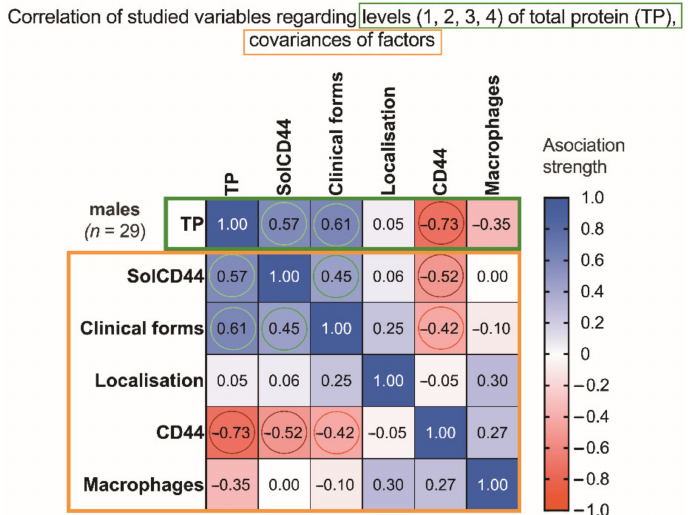
Figure 3. Association strength of studied variables: SolCD44, clinical form of leukoplakia, localiza- tion of oral leukoplakia, mean number of CD44 expressed in epithelial layers in leukoplakia tissue, mononuclear cells (macrophages under the basal membrane), and gender of patients with leukoplakia ( n = 29) regarding levels of total protein (and covariances), in the male group. Spearman’s rank corre- lation matrix: numbers in squared cells show value of correlation coefficient, indicating association strength; colored circles denote most the significant associations (red, negative; green,